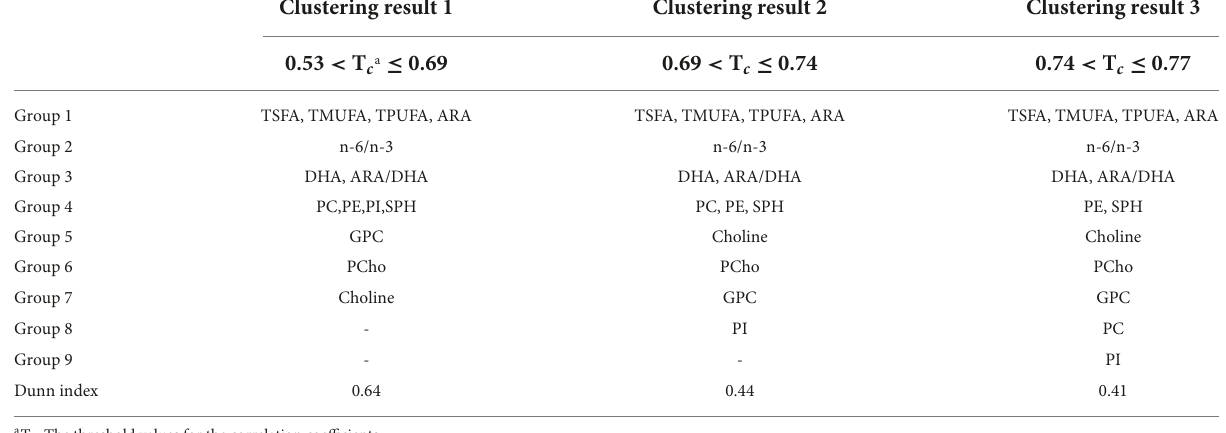
TABLE 5 Correlation and grouping of the 14 nutrients.